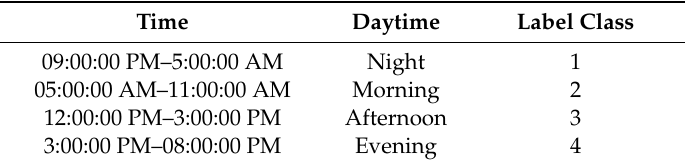
Table 2. Class labels generated for 1D-DCNN .